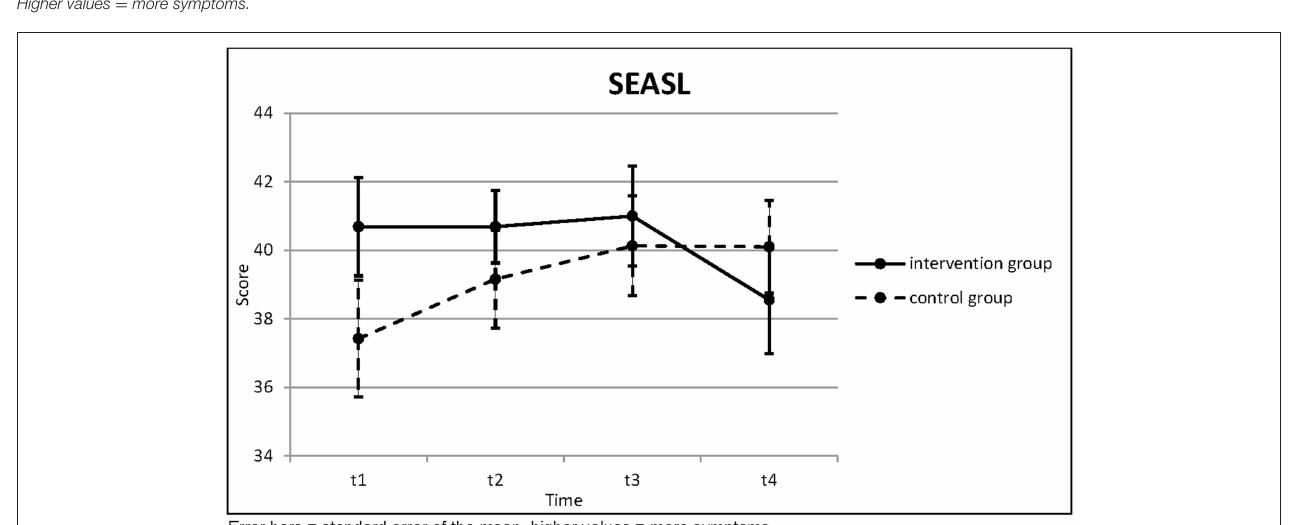
FIGURE 3 | Work and Social Adjustment